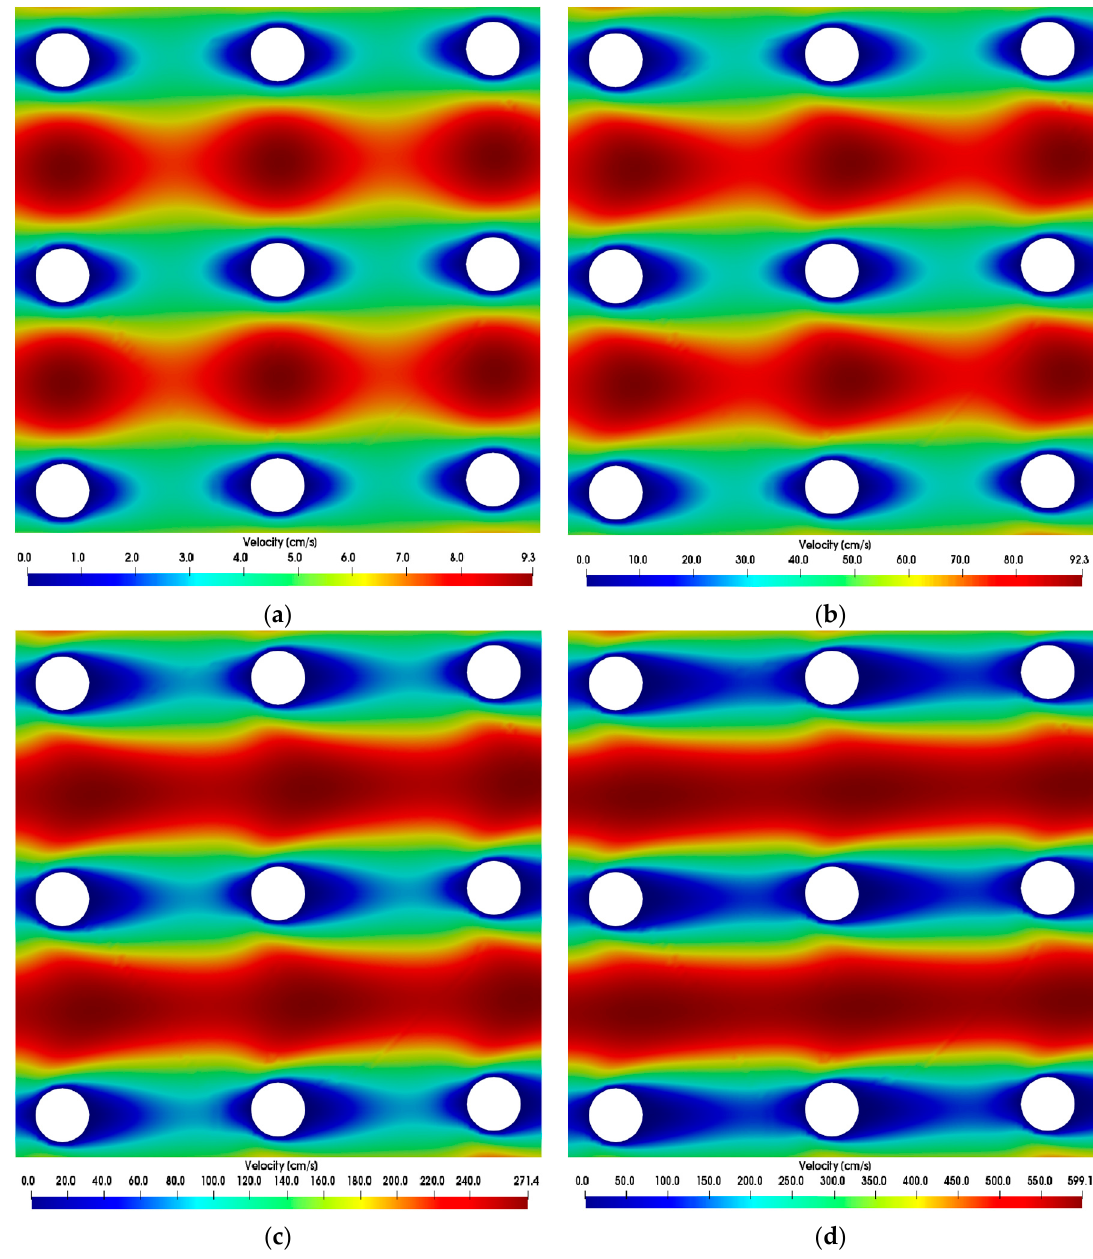
Figure 7. Simulations show emerging asymmetric flow between posts at di ff erent Reynolds numbers. The direction of flow is from left to right. Color scales refer to the velocity magnitude. ( a ) Re = 0.76, ( b ) Re = 7.63, ( c ) Re = 22.86, ( d ) Re =